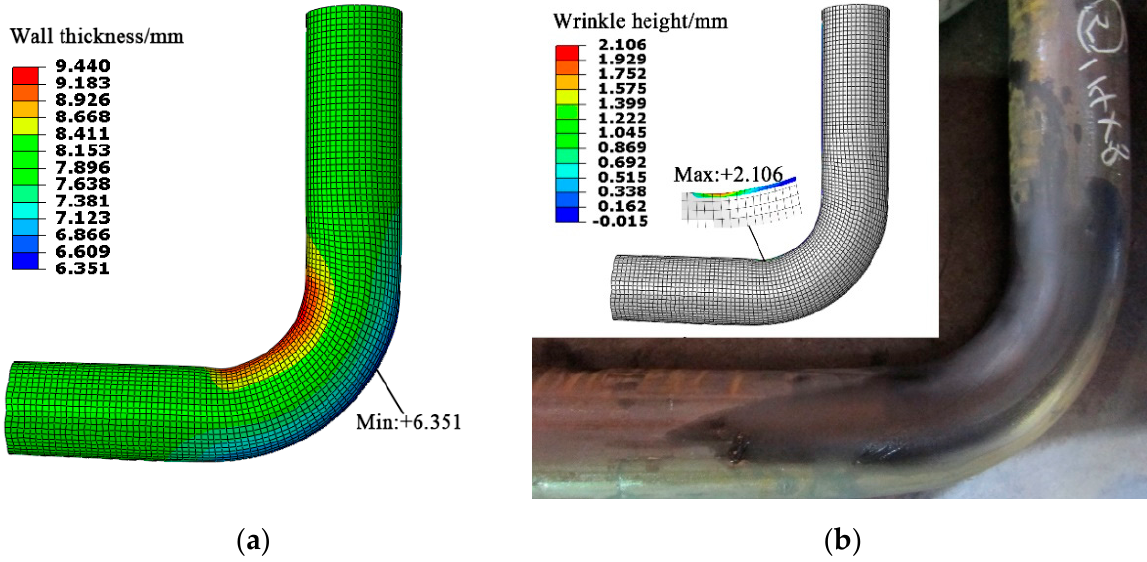
Figure 5. The distribution of wall thickness and wrinkle height of the bent tube: ( a ) the distribution of wall thickness and ( b ) the distribution of wrinkle height.